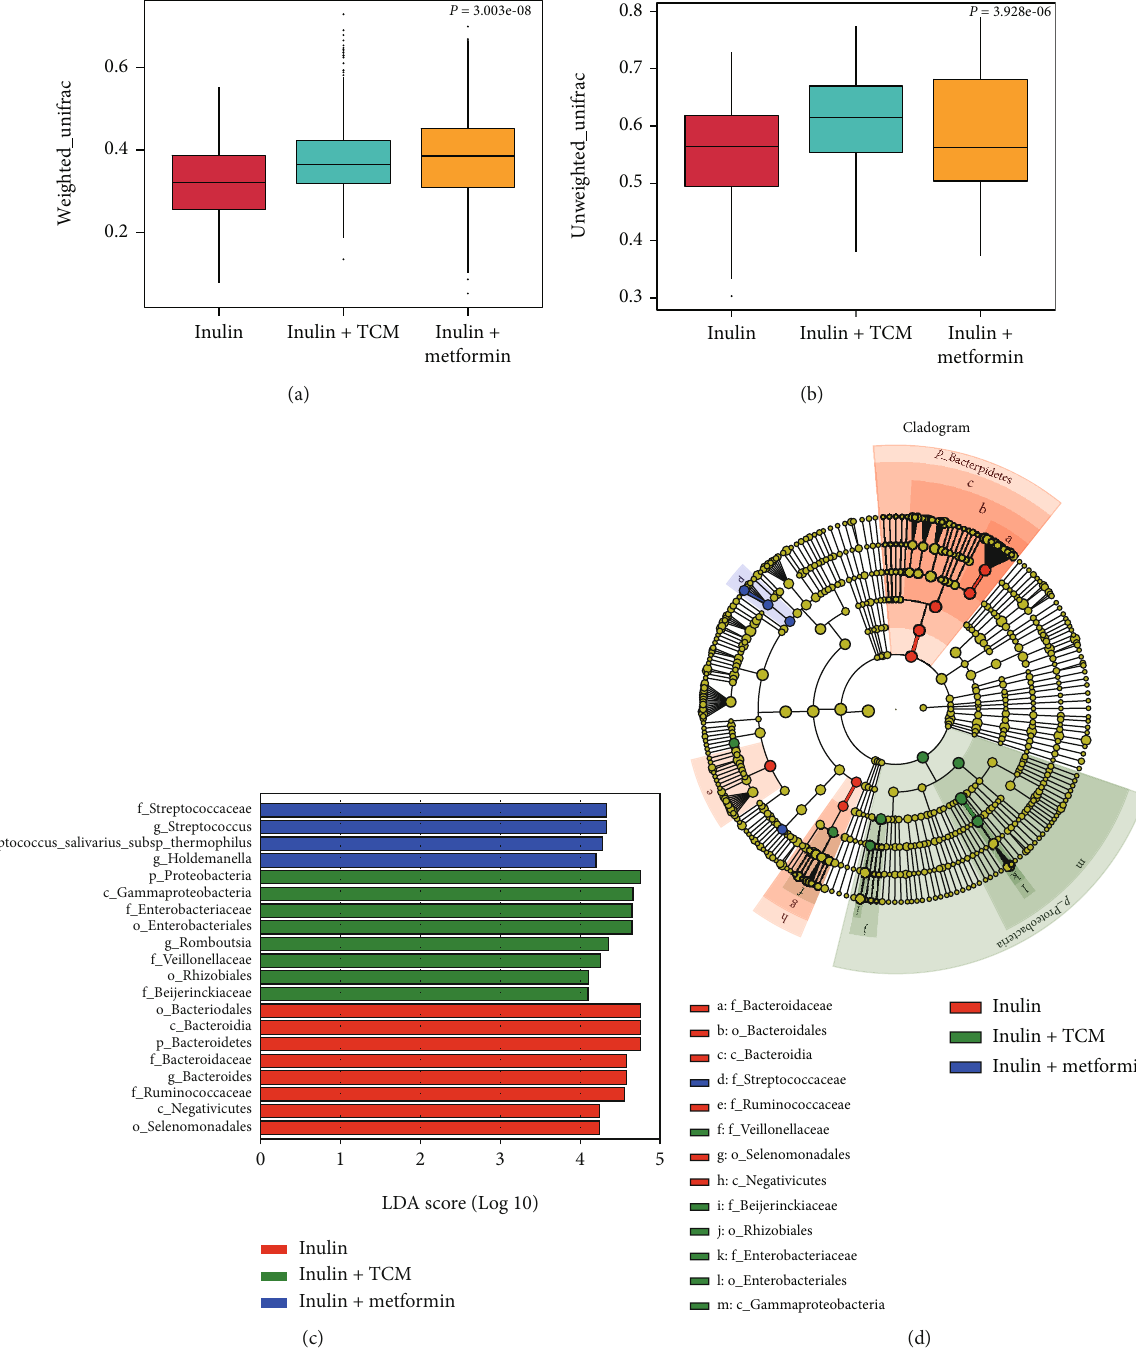
Figure 2: Comparison of β diversity among intestinal bacteria using weighted/unweighted UniFrac and LEfSe analyses after 6 months of intervention. (a, b) Weighted/unweighted UniFrac analysis of β diversity shows signi fi cant di ff erences among intestinal bacteria ( n = 20 per group; Kruskal – Wallis χ 2 test). (c, d) Results of LEfSe assays show di ff erences in gut bacteria abundance among groups and e ff ect size of each di ff erentially abundant bacterial taxa ( n = 20 per group; signi fi cantly di ff erent, Wilcoxon rank sum